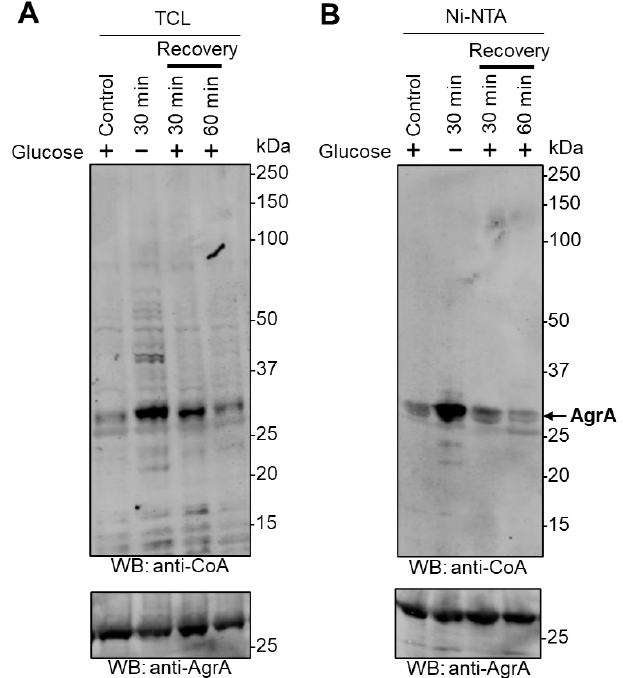
Figure 3. Glucose deprivation induces CoAlation of Sa AgrA in E. coli . The expression of Sa AgrA was induced with 0.1 mM IPTG for 20 min at 37 °C. Cells were then transferred and cultured in medium lacking glucose or any other source of carbohydrates for 30 min. The cultures of glucose-starved bacteria were then supplemented with 20 mM glucose and incubated at 37 °C for the indicated times to allow recovery. ( A ) Protein CoAlation in total protein extracts was examined by anti-CoA Western blot. ( B ) Overexpressed Sa AgrA was purified using Ni-NTA Sepharose and analyzed by Western blotting with anti-CoA antibody. The respective amounts of Sa AgrA are shown by Western blot with anti-AgrA antibodies. The figures are representative of at least three independent repeats.